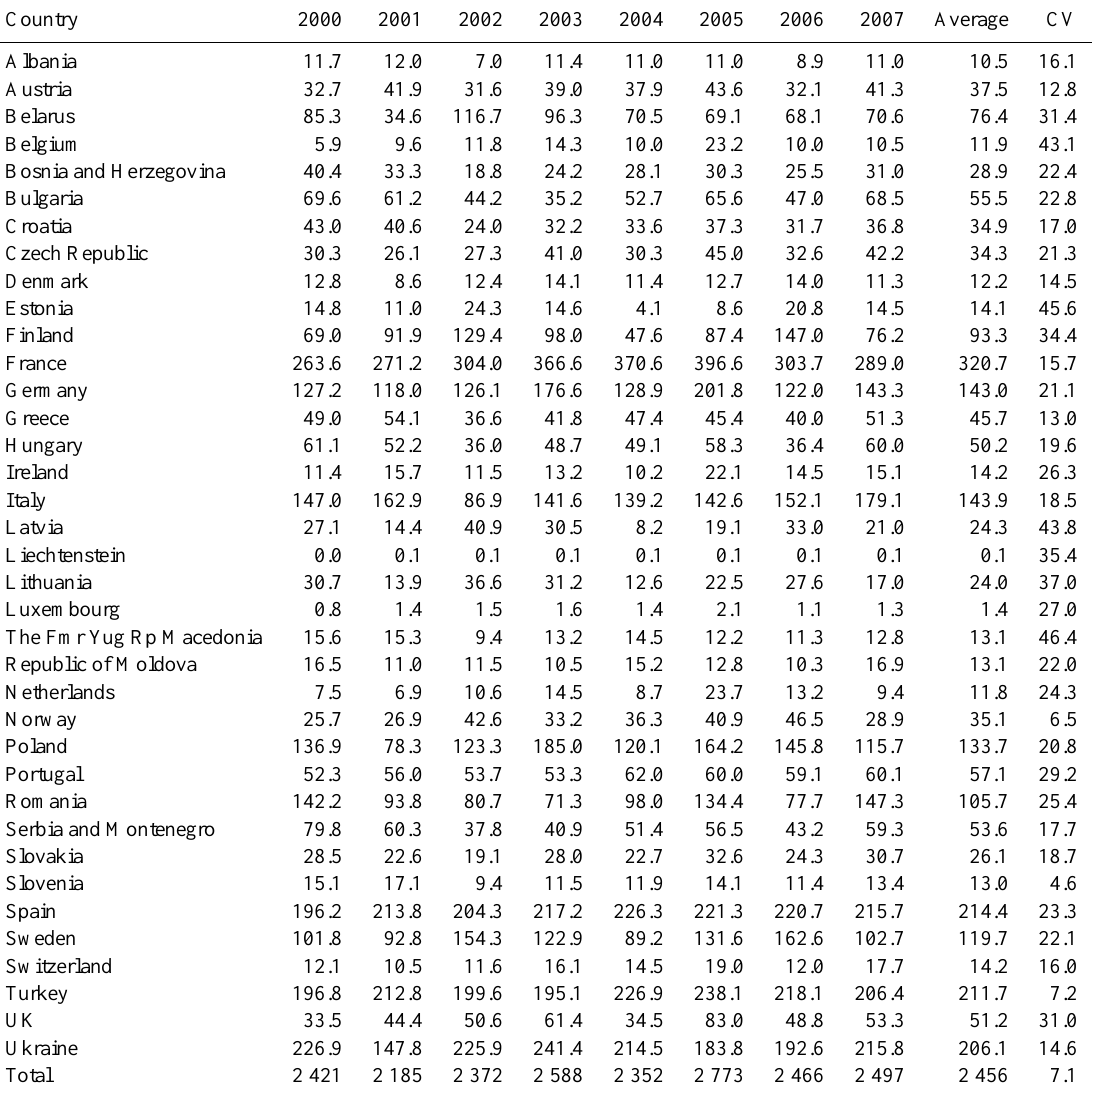
Table 4. Annual GPP sums for the period 2000–2007 per country as calculated by BETHY/DLR in MtCa − 1 . CV stands for coefficient of variation